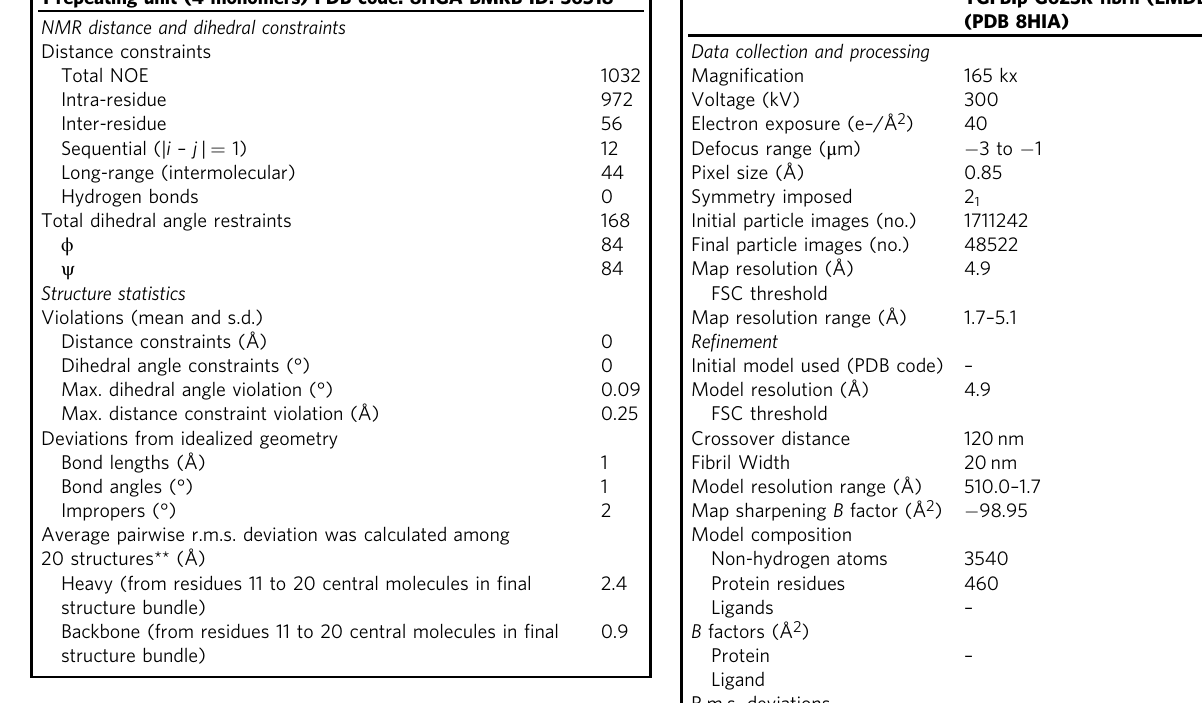
(Fig. 2a). An analysis of cryo-EM micrographs of fi brils in complex with L-PGDS indicates that bending of the fi brils, an observation notably only in the presence of L-PGDS, is accom- panied by a 4-fold reduction in the persistence length from 12500 nm down to 3300 nm and considerable shortening of the fi bril contour length (Fig. S9) as the direct consequence of L-PGDS binding.